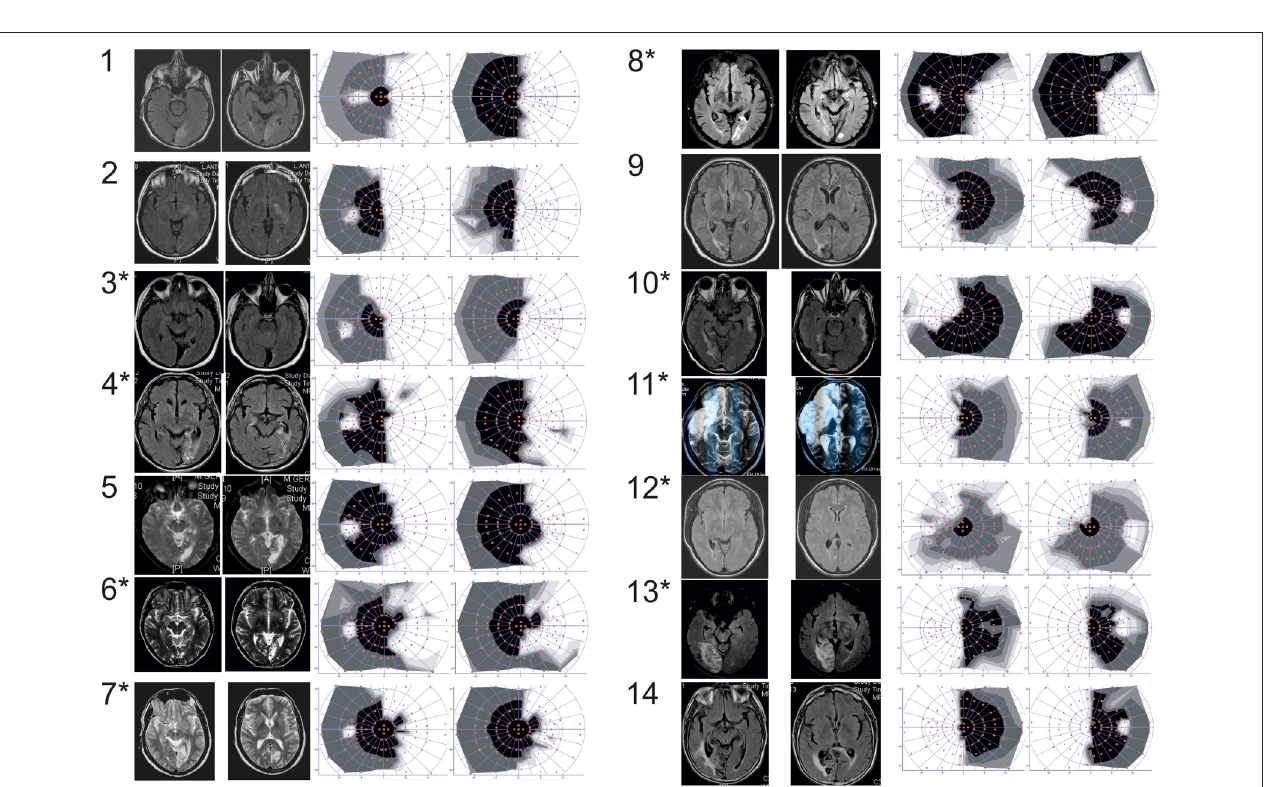
FIGURE 1 | Patients number. Patients with ( * ) or without (no * ) positive slope, MRI (either T2 or FLAIR axial sequences) and 30 ◦ central visual field (automated static system, Metrovision ® , Pérenchies, France) in the overall group of patients. White part of the visual field refers to the blind part of the visual field.